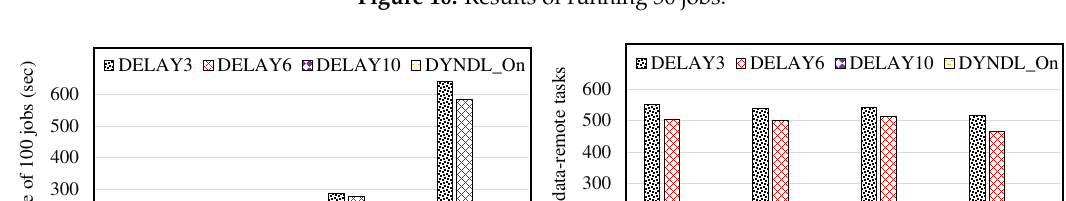
Figure 10. Results of running 50 jobs.